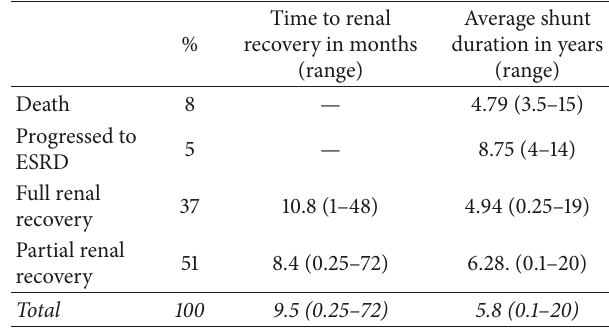
Table 7: Renal outcomes after shunt nephritis treatment. Full renal